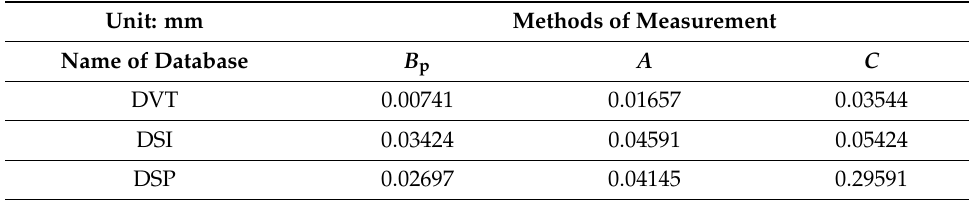
Table 8. Table of cross-section diameter measurement result via STD. Unit: